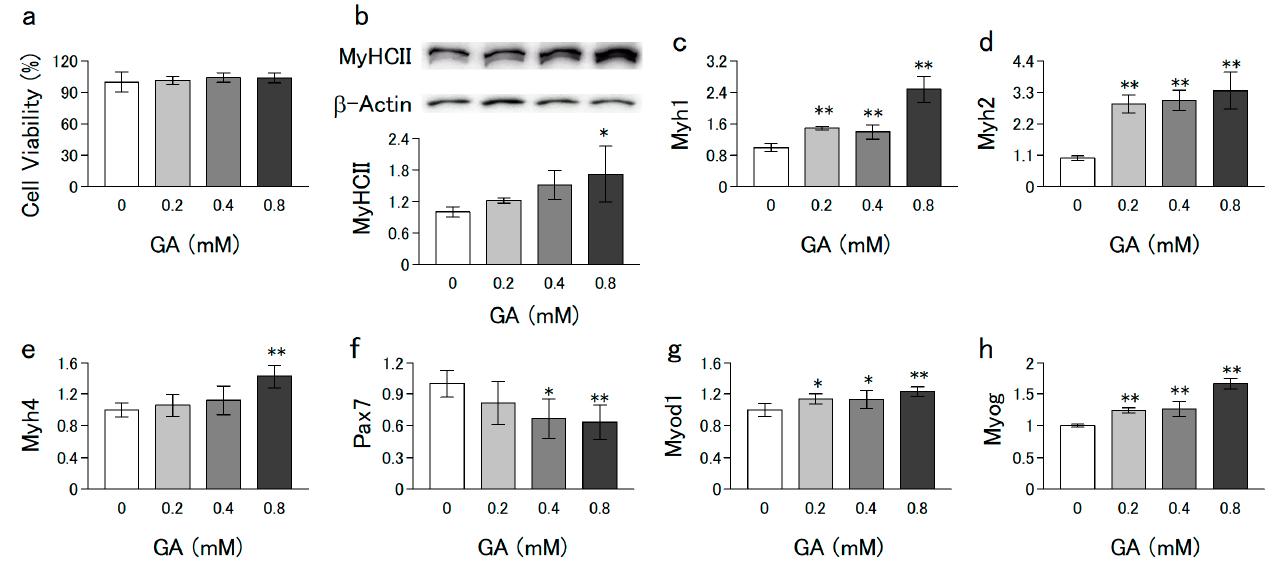
Figure 1. Effect of GA on the viability and differentiation of C2C12 cells. C2C12 cells grown to subconfluence in a growth medium (without GA) were further cultured in a differentiation medium with or without GA for 6 d. ( a ) Cell viability was measured using the neutral red assay. ( b ) Western blot images of MyHC II, a biomarker protein for differentiation, and β -actin, an internal control. ( c – e ) mRNA levels of MyHCII encoding isoforms ( Myh1 , Myh2 , and Myh4 ). ( f ) mRNA levels of Pax7 , a satellite cell marker. ( g , h ) mRNA levels of myogenic regulatory factors ( Myod1 and Myog ). mRNA levels were measured using qPCR. Values are represented as mean ± SD of three independent experiments. Data were analyzed using a one-way analysis of variance followed by Dunnett’s post hoc comparison tests. The mean value was significantly different from that of the control: ** p < 0.01, * p < 0.05.